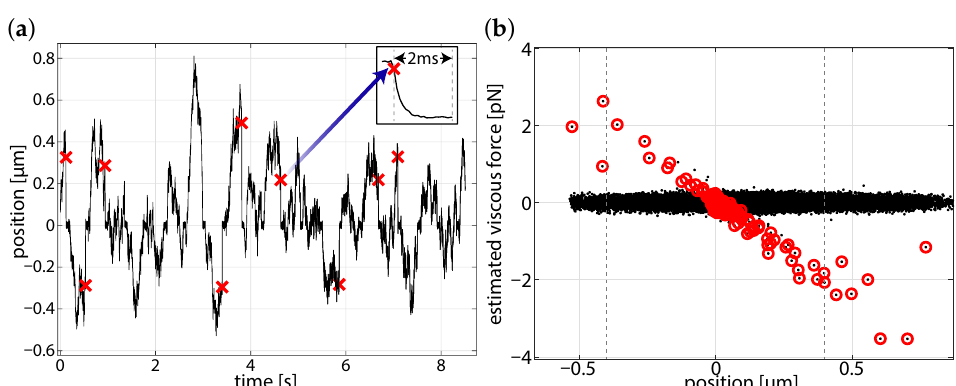
Figure 5. Observations of a 2µm diameter particle being successively trapped and released. ( a ) Position trace with the start of each in-fall event marked in red. Inset shows a close up an instance of a fall event up to 2ms after the fall. ( b ) position-force plot with selected in-fall trajectories marked in red dashed gray lines represent the 400nm maximum starting